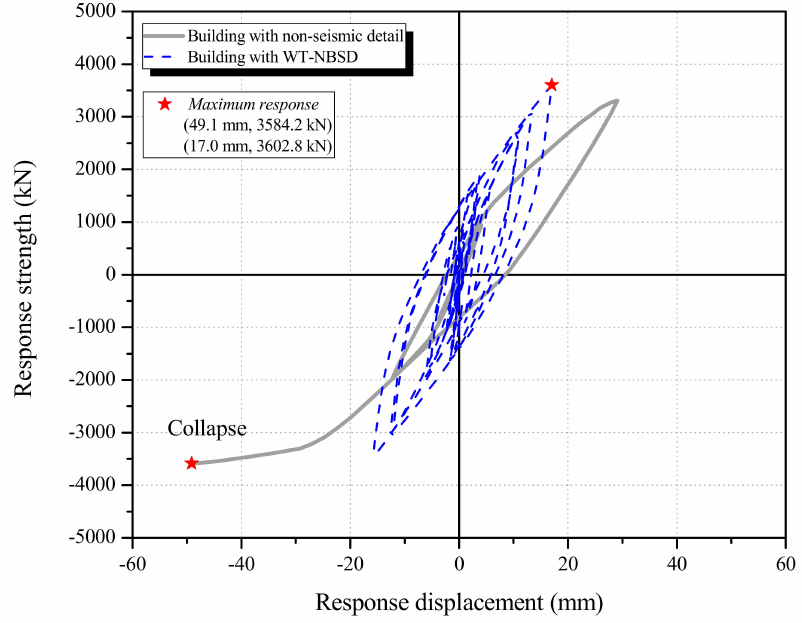
Figure 29. Seismic response load-displacement curves of the reference building and the building retrofitted with NBSD (firsts floor). Table 15. Comparison of the maximum seismic response and damage before and after